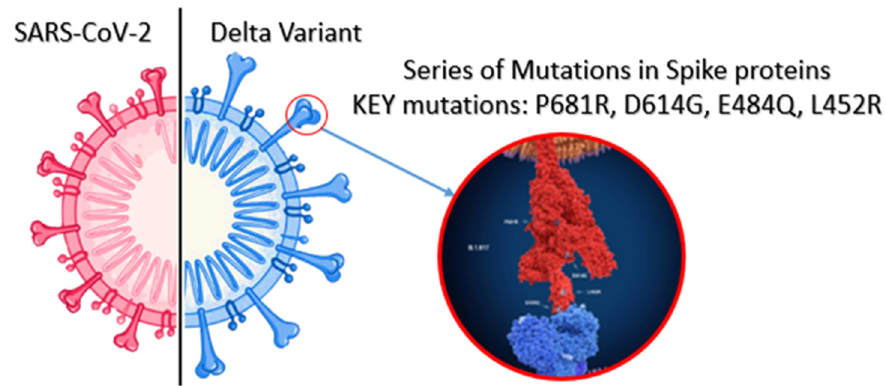
Figure 1. Comparison structure of SARS-CoV-2 and Delta variant.